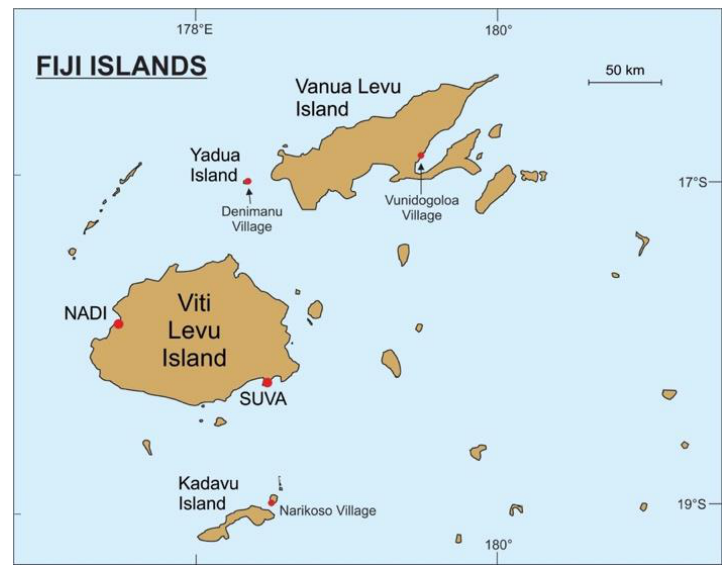
Figure 1. Map of Fiji showing the two case study sites (Vunidogoloa and Denimanu villages).